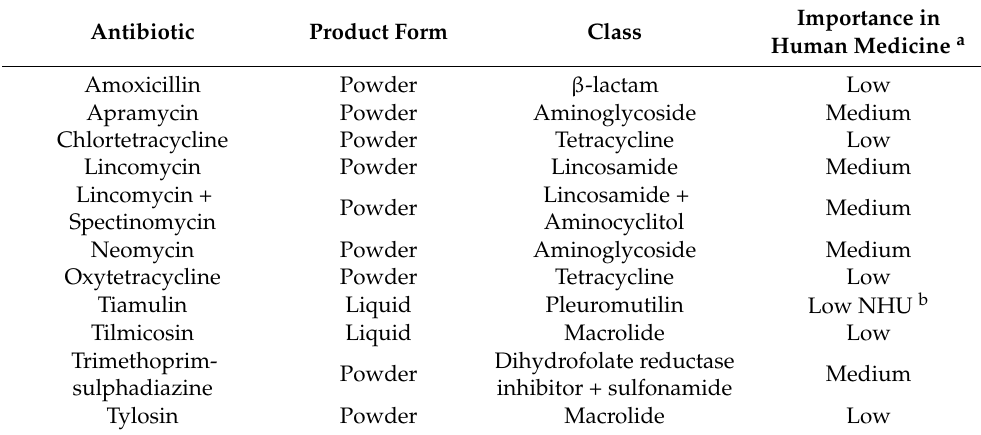
Table 2. Antibiotics currently and recently administered in-water to pigs on 25 single-site and multi-site pig farming